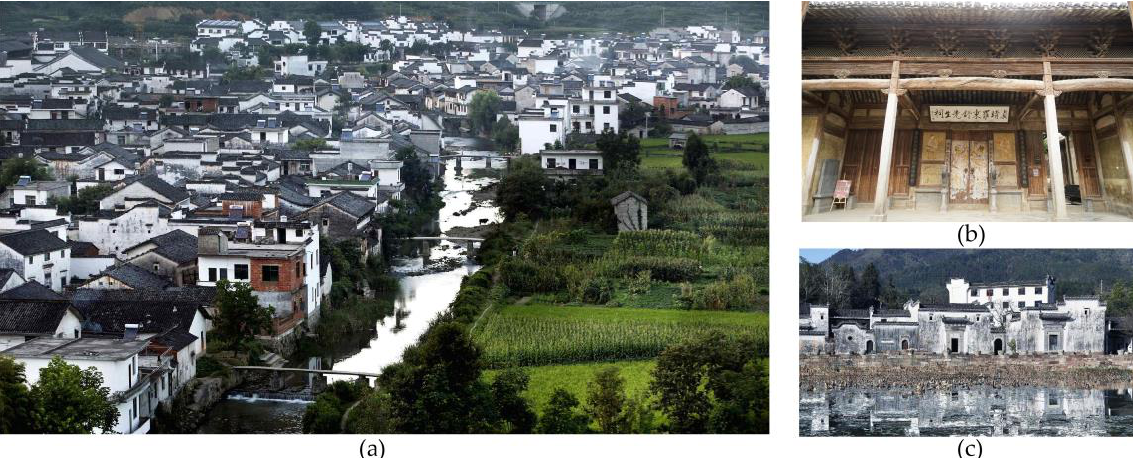
Figure 2. Photos of Chengkan Village. ( a ) Overall view. ( b ) Luo DongShu Ancestral Temple. ( c ) Ming Dynasty architecture.